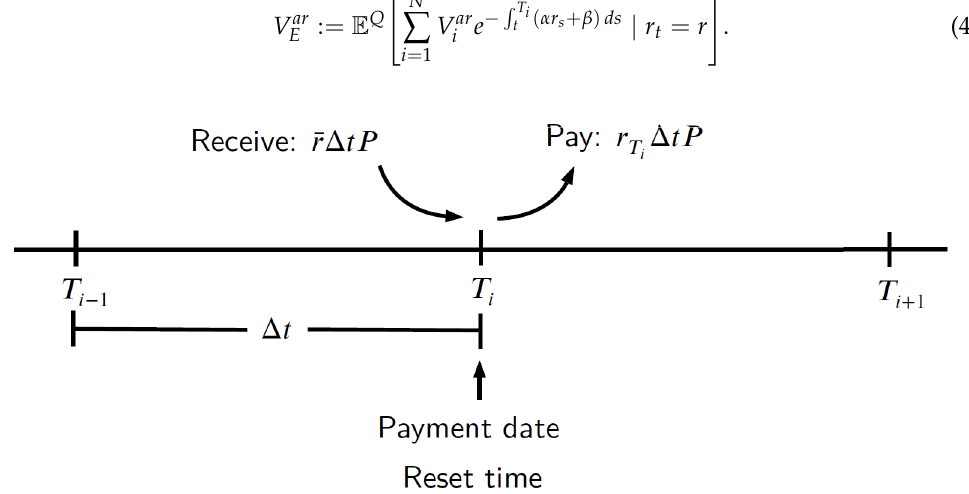
Figure 5. Cash flow of an arrears swap at time T